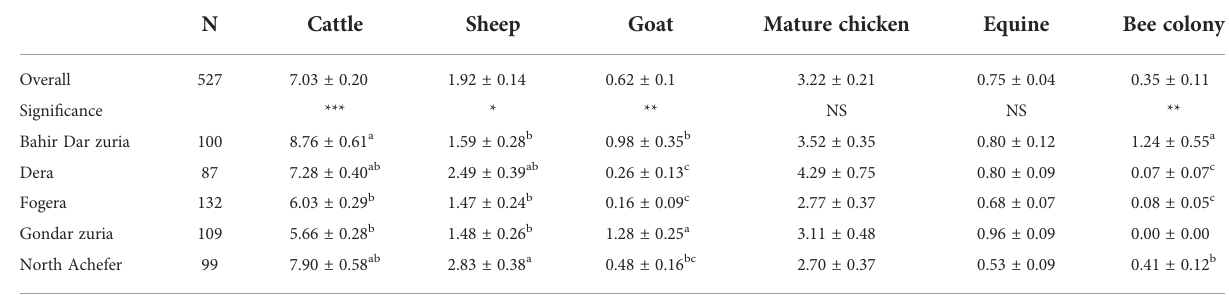
TABLE 3 Livestock holdings of households in the study districts.